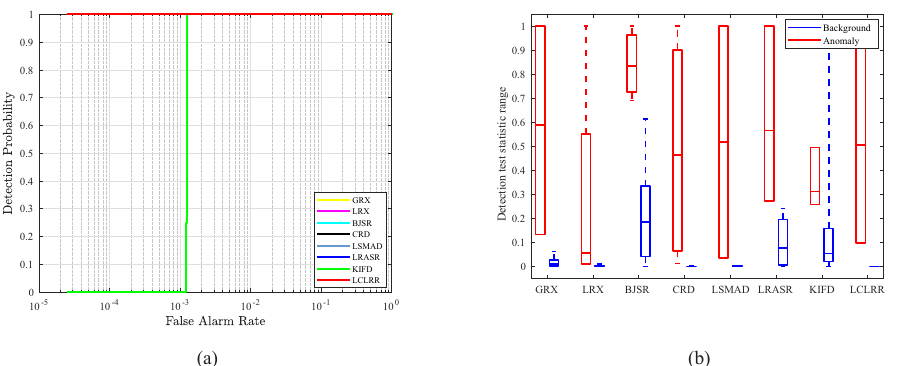
Figure 4. The ROC curves and box plots of different algorithms for the simulated dataset. ( a ) ROC curve. ( b ) box plot.